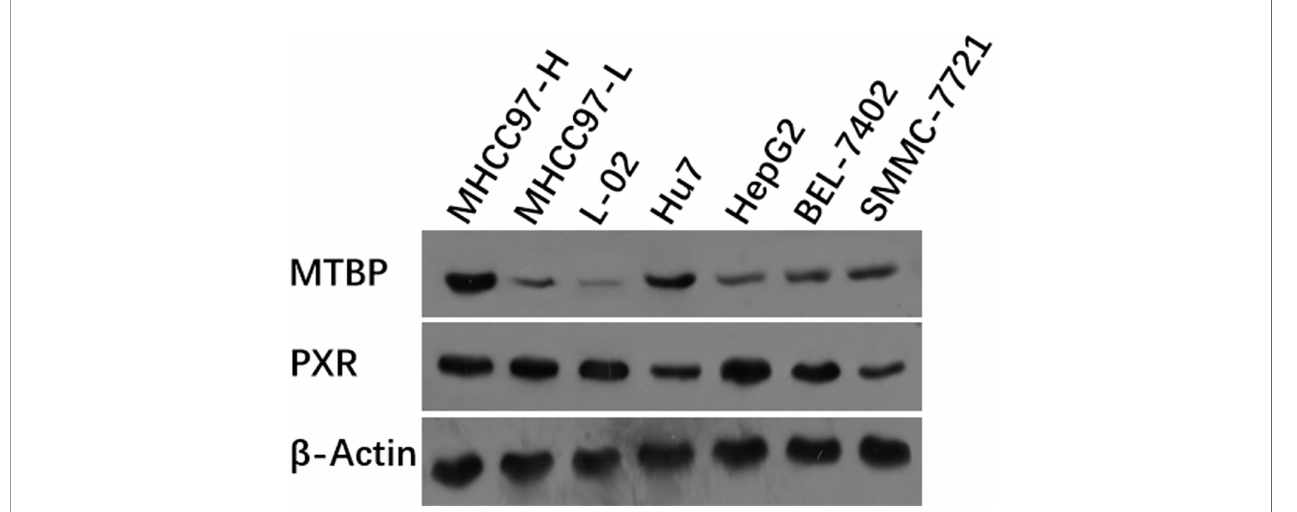
FIGURE 1 | The expression of the highest level of MTBP among the hepatic cell lines. The hepatic cell lines MHCC97-H (a highly aggressive HCC cell line), MHCC97-L (a lowly aggressive HCC cell line), L-02 (a non-tumor hepatic cell line), Hu7 (a HCC cell line with dysfunction of P53), HepG2 (a HCC cell line), BEL-7402 (a HCC cell line) and SMMC-7721 (a HCC cell line) were cultured and harvested for western blot experiments. The protein levels of MTBP in these cells were examined by the antibodies. The b -Actin was chosen as the loading